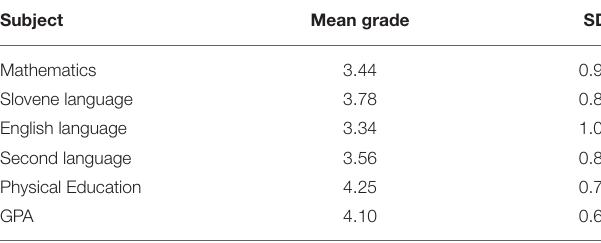
TABLE 3 | Descriptive statistics for academic performance.